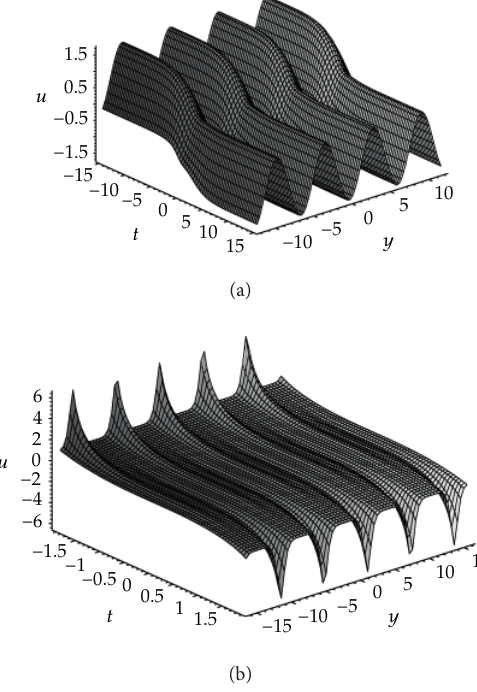
Figure 1: (a) The figure of 𝑢 1 as 𝑝 = 1 , 𝑞 = 1 , 𝑟 = 2 , 𝜏(𝑦) = sin (𝑦), 𝜉 0 = 0 , 𝑥 = sech (𝑡) . (b) The figure of 𝑢 3 as 𝑝 = −1, 𝑞 = = 0, 𝑥 = sin (𝑡) . 1, 𝑟 = −1, 𝜏(𝑦) = − cos (𝑦), 𝜉 0